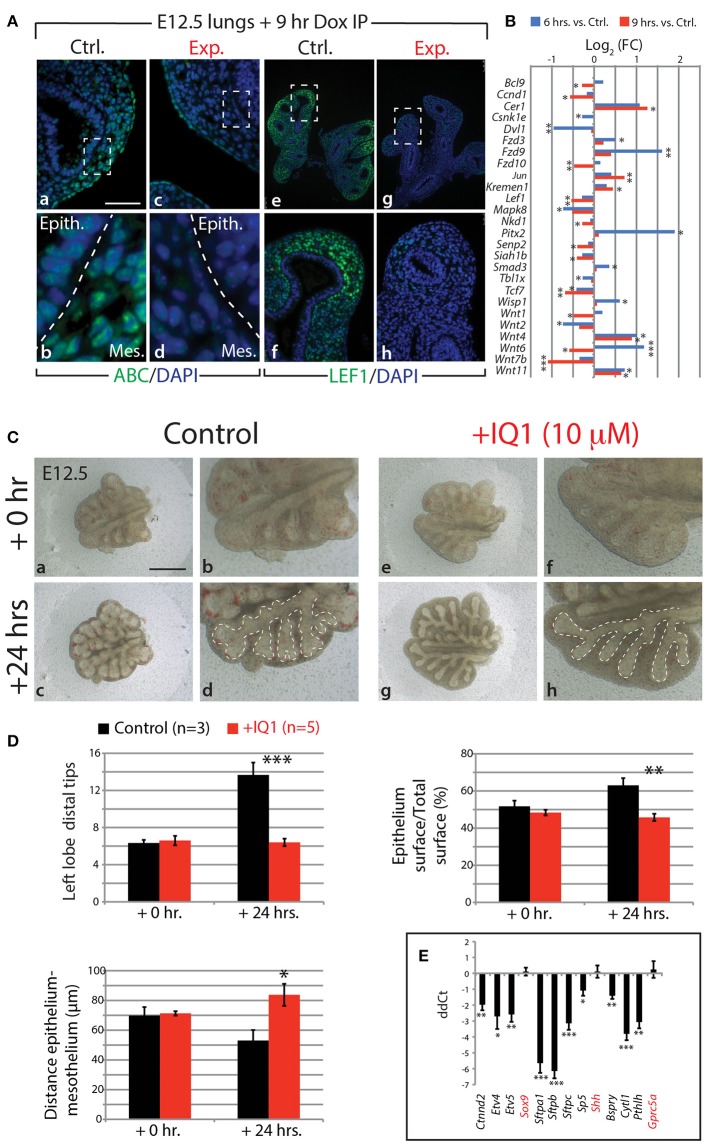
FGF10 activity is primarily mediated through ß-catenin/EP300 (A) IF for transcriptionally active ß-catenin (ABC) and for LEF1 in control and experimental lungs. Scale bar: (a,c) 50 μm; (b,d) 15 μm; (e,g) 300 μm; (f,h) 75 μm. (B) Gene expression changes in the canonical WNT pathway at 6 and 9 h vs. controls. (n = 3; see Materials and Methods for details on the statistical analysis of gene arrays; *p-value < 0.05, **p-value < 0.01, ***p-value < 0.001). (C) E12.5 lungs cultured with (experimental) or without (control) IQ1 for 24 h. Note the similarity to FGF10 inhibition on the branching in experimental lungs. Scale bar: (a,c,e,g) 500 μm; (b,d,f,h) 250 μm. (D) Quantification of branching defects in experimental vs. control lungs. (E) qPCR analysis on a subset of the “FGF10 gene signature.” Except for Sox9, Shh, and Gprc5a, inhibition of ß-catenin/EP300 produces a similar down-regulation of genes as in FGF10 inhibition. [(D,E) Data are presented as mean ± SEM; significance determined by unpaired two-tailed Student's t-test; n = 3 for control and n = 5 for experimental; *p-value < 0.05, **p-value < 0.01, ***p-value < 0.001].